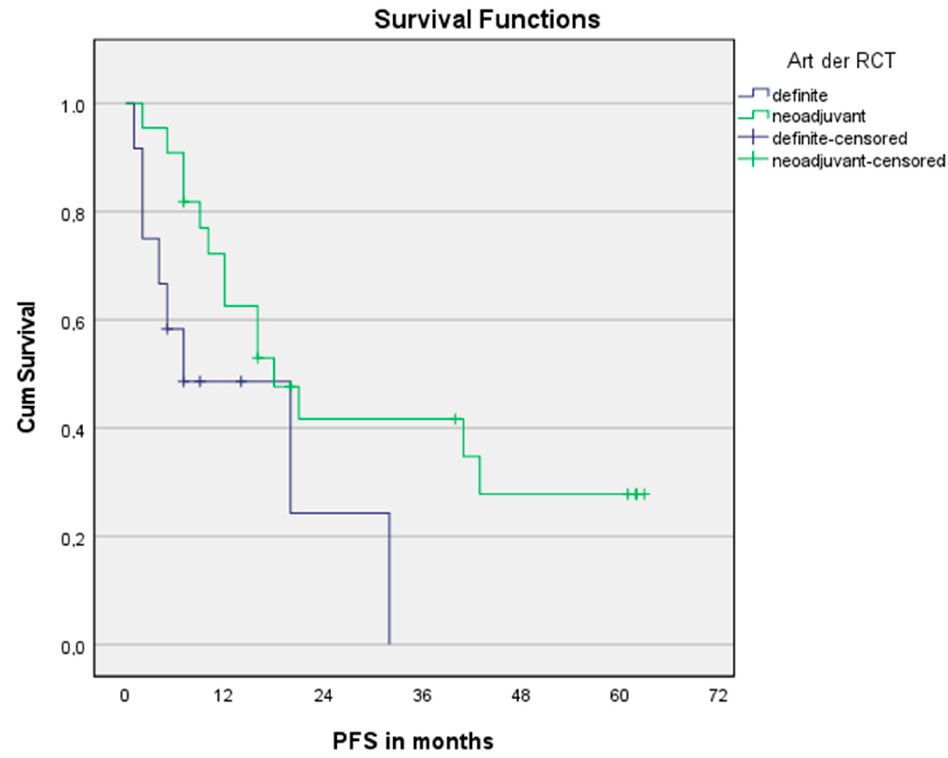
Figure 4. Progression-free survival for nCRT and dCRT. n = 34. Log Rank (Mantel-Cox): p = 0.057. Detailed results of univariate Cox regression analysis are demonstrated in Table